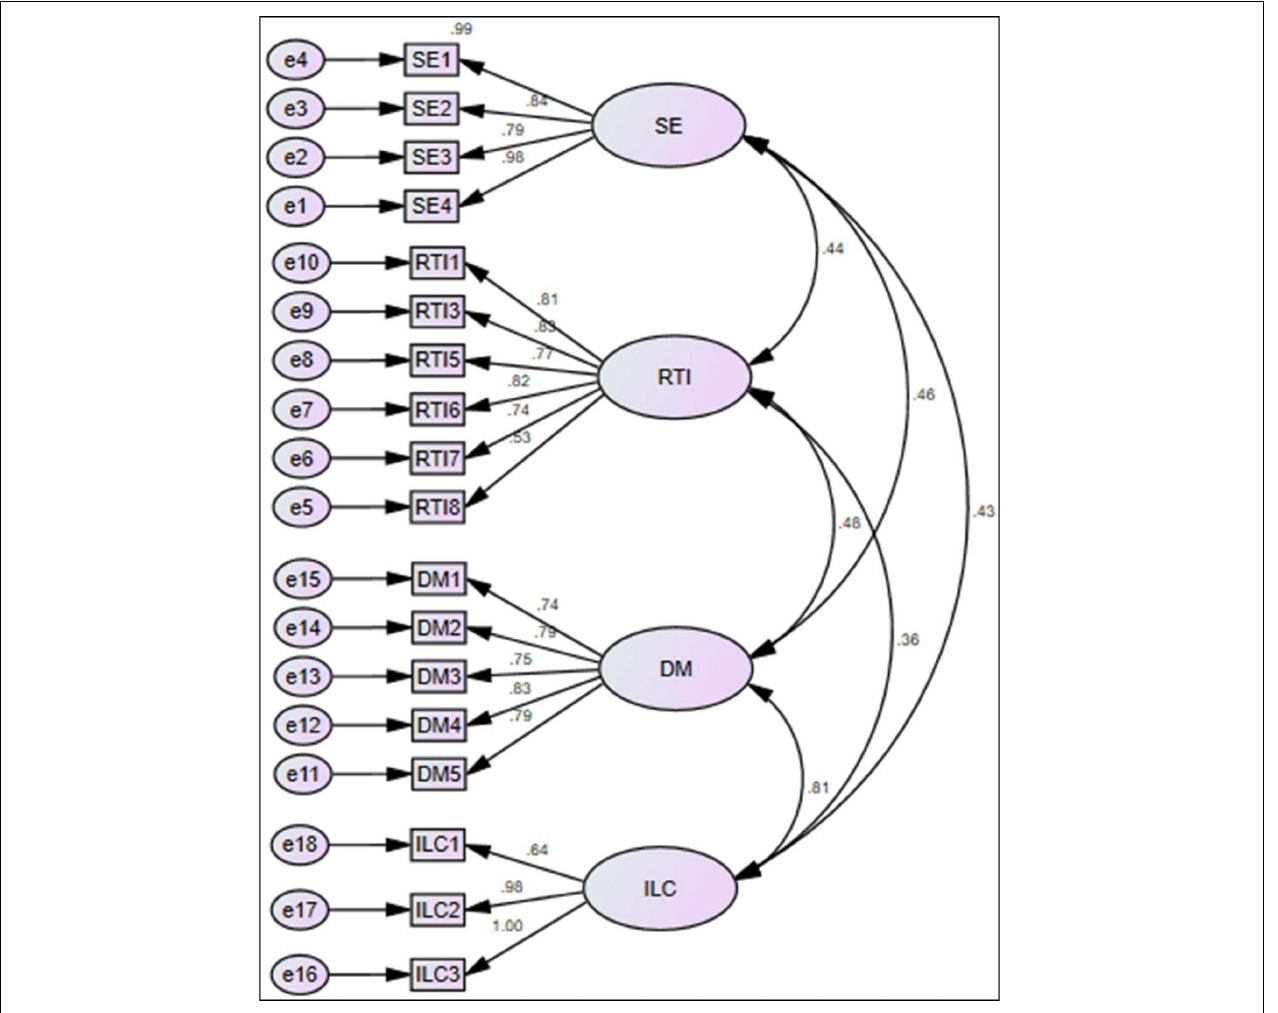
FIGURE 2 | Measurement model assessment. Indicated that the factor loadings of the items are larger than 0.50 and indicated valid convergent